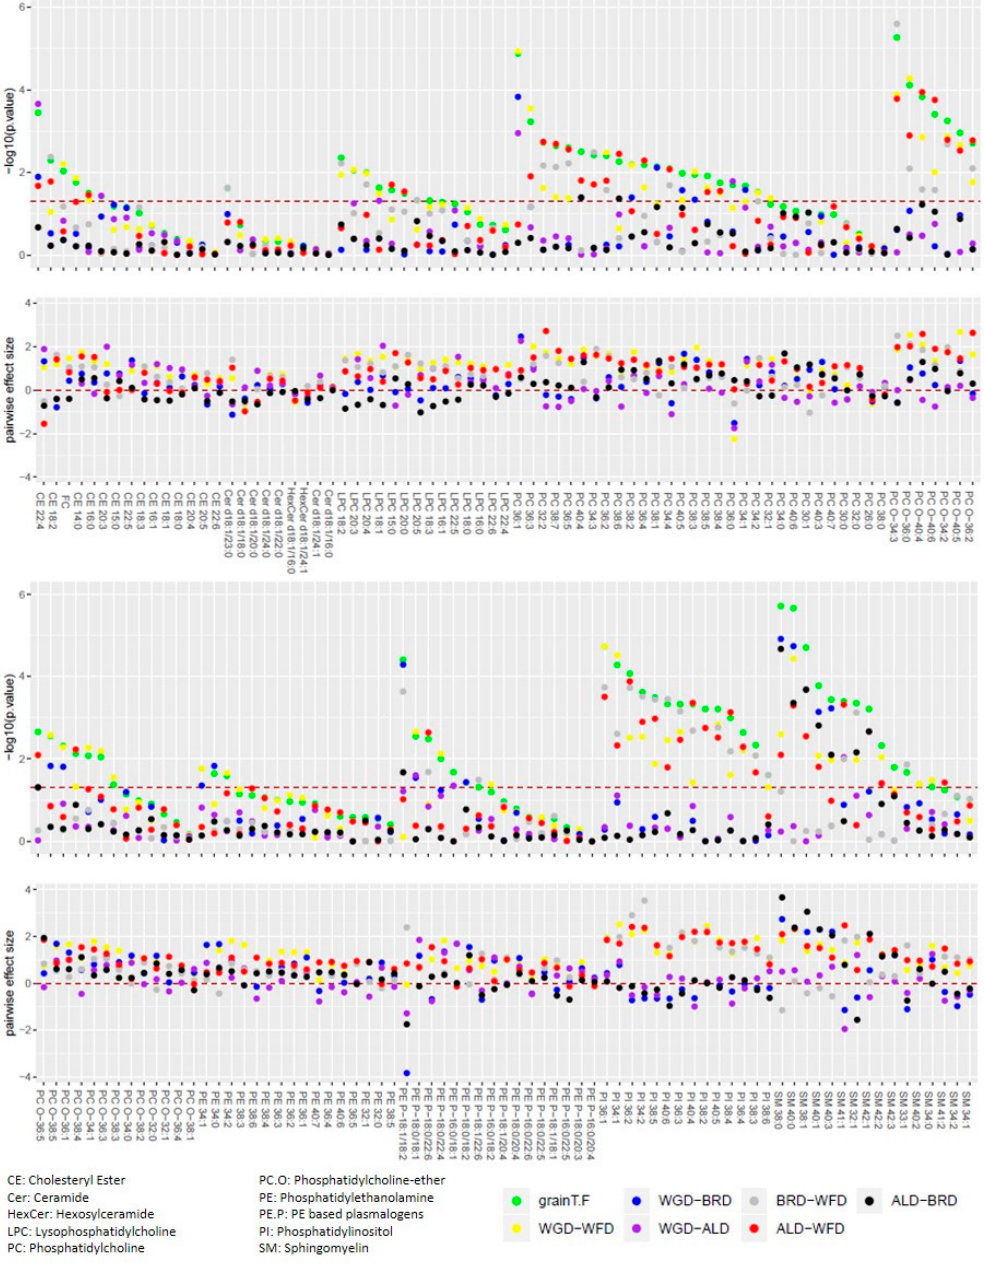
Figure 2. p-values and effect sizes for plasma lipids sorted by class. Upper panel: For each lipid the p-values are represented for the F-test (green dots), indicating differences between the diets and for the post-hoc Tukey test, indicating pairwise comparisons (other colored dots). Lower panel: The pairwise Cohen’s effect size (difference between the two means divided by the pooled standard deviation) is given.